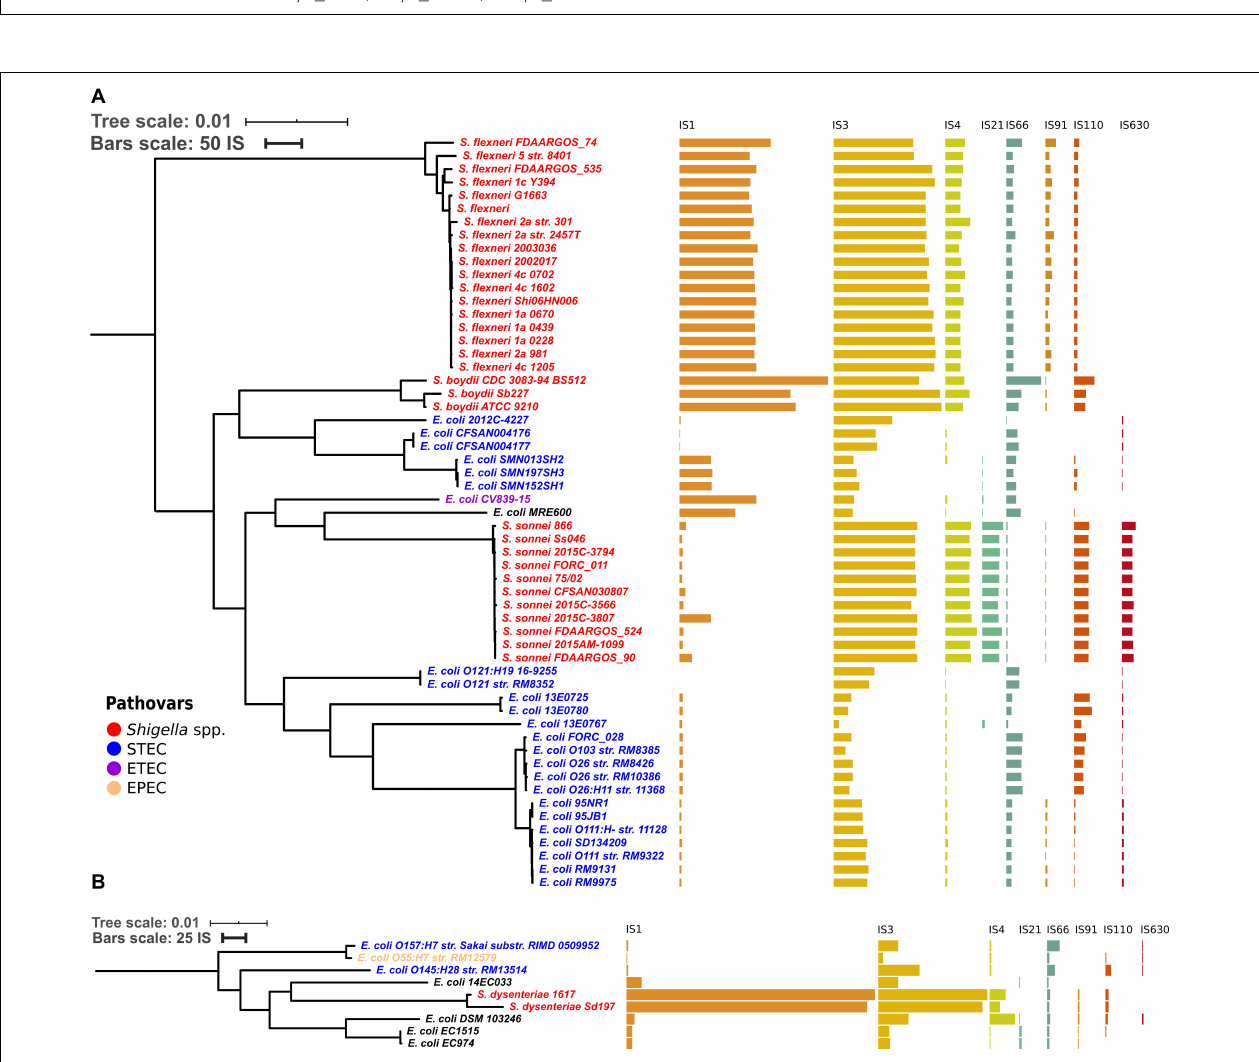
FIGURE 3 | Distribution of IS families in panel (A) a part of phylogroup B1 and (B) phylogroup E. The bars indicate the number of ISs in each family.